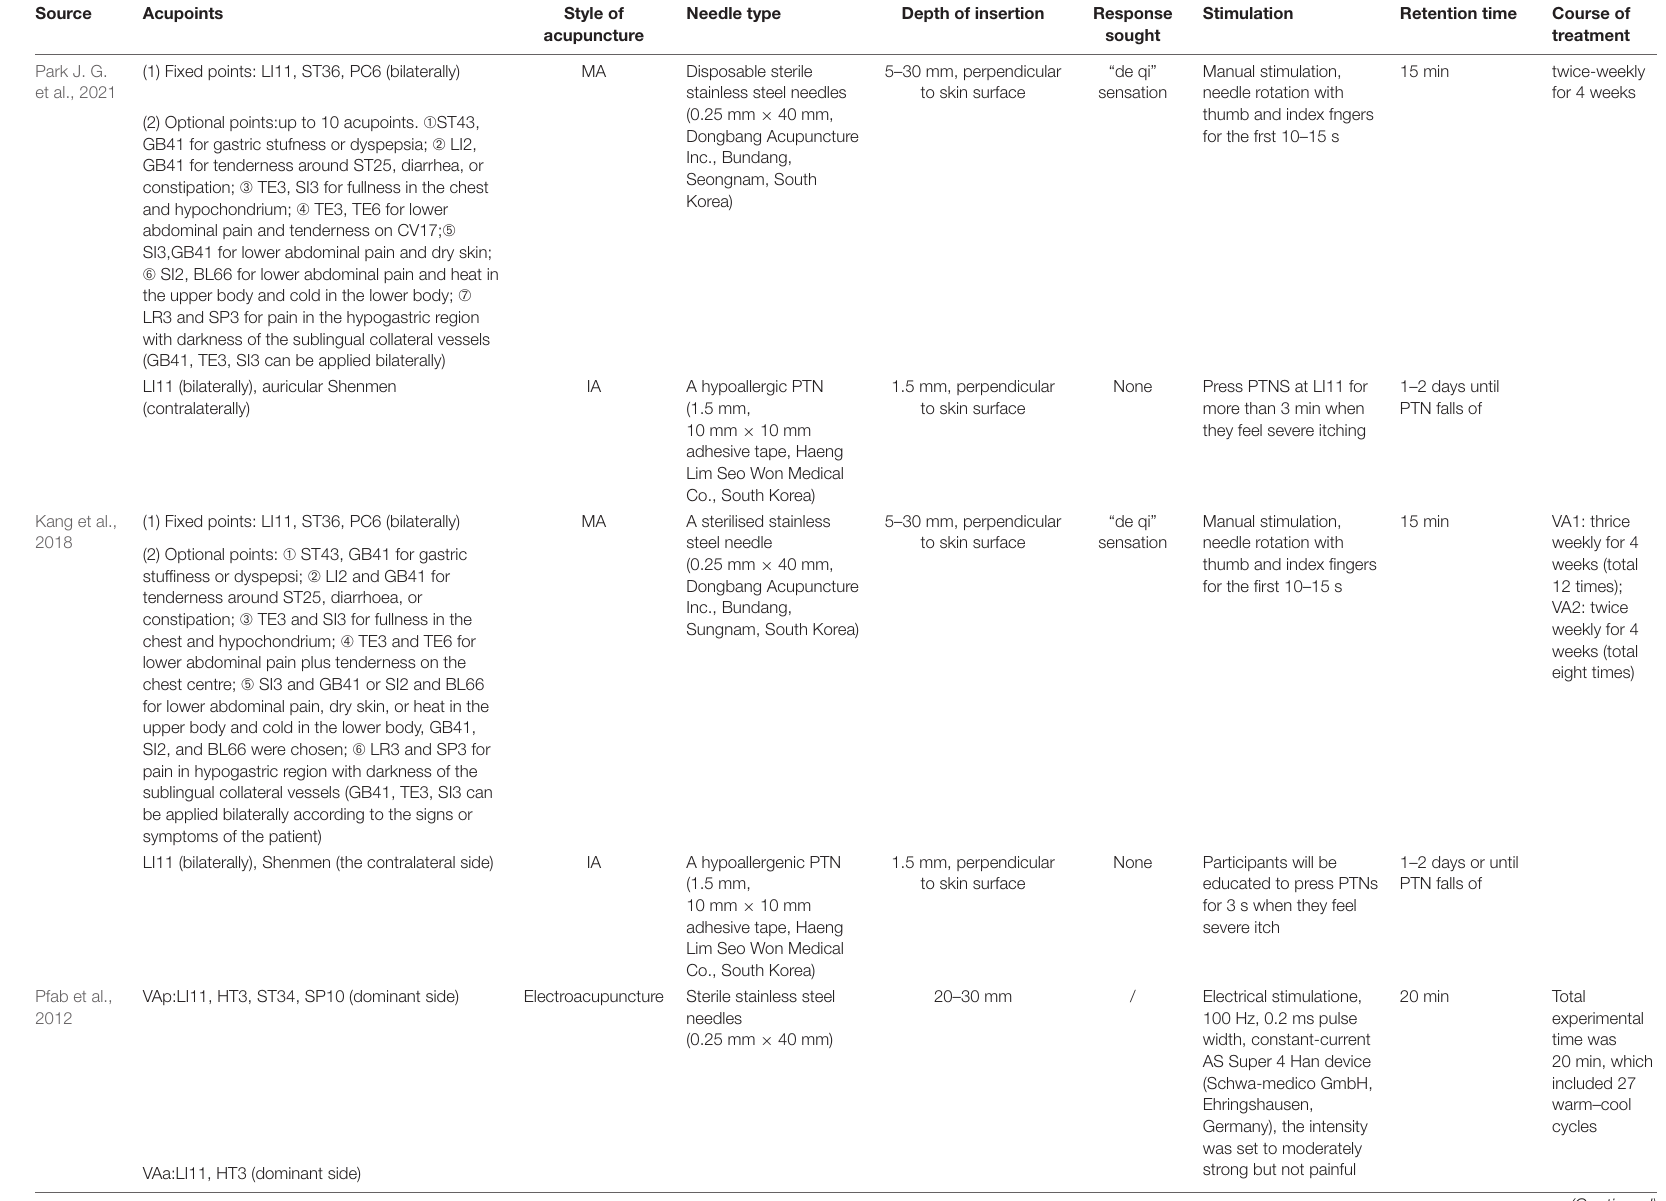
TABLE 2 | Acupoints and methods for relieving